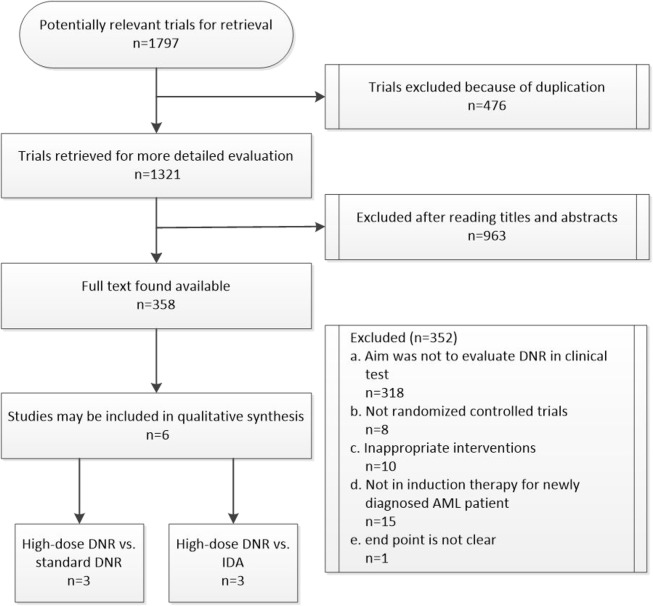
Flow diagram depicting identification and retrieval of eligible studies for inclusion.